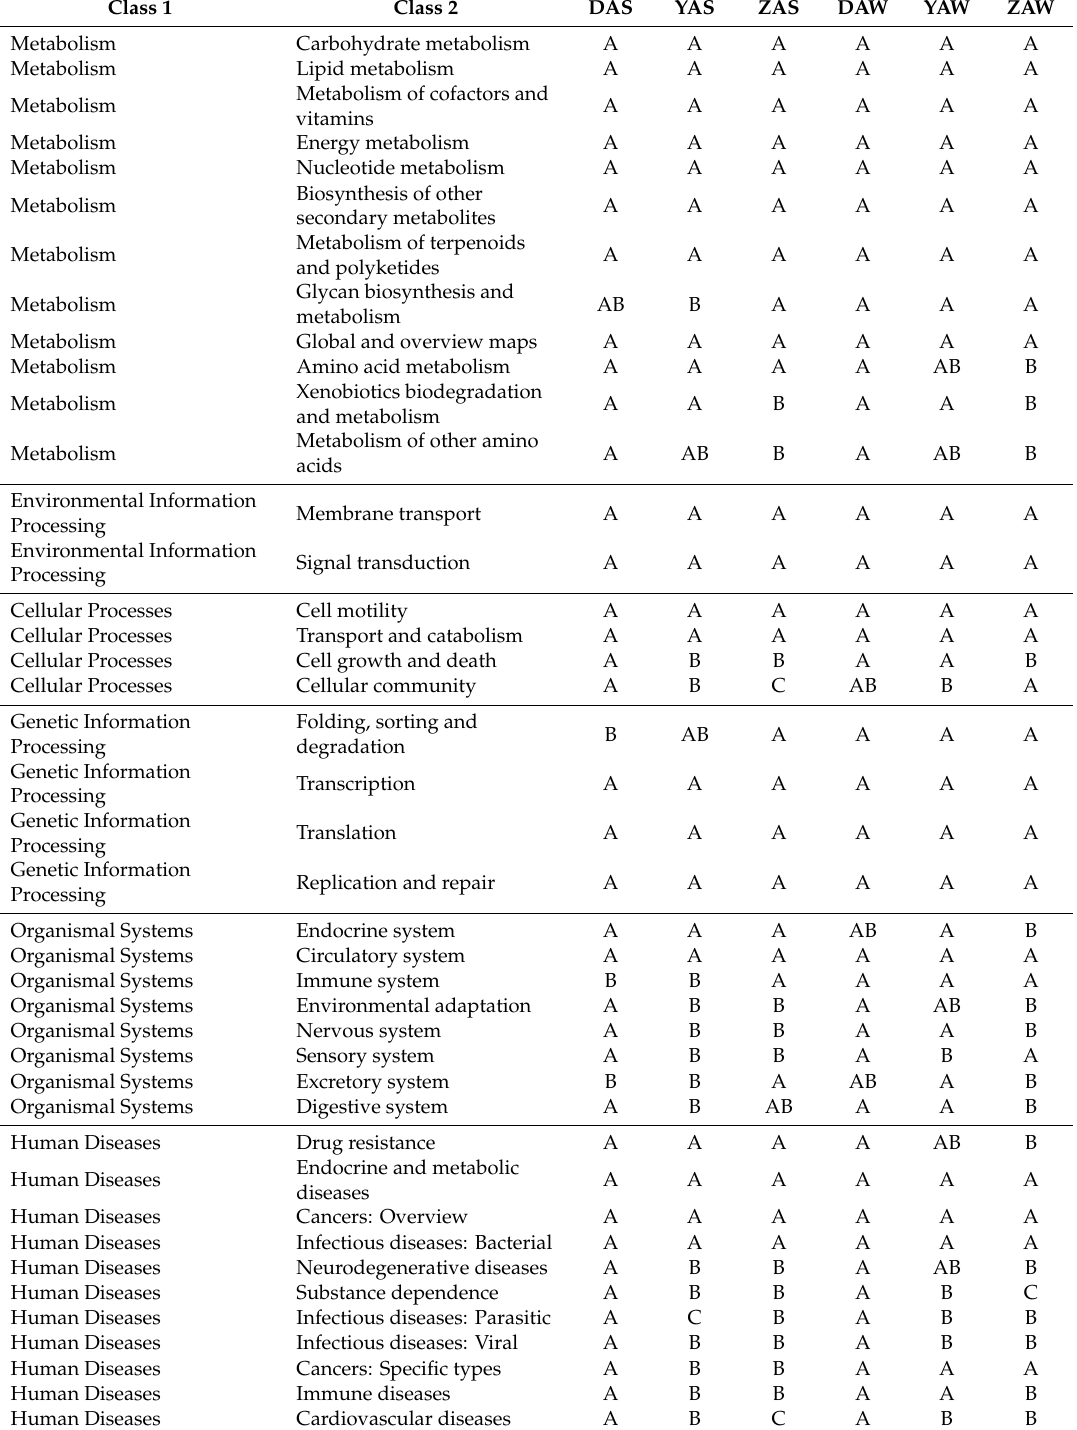
Table 4. Multiple mean comparison of gene abundance according to bacterial functions in di ff erent sludge samples based on KEGG level 2